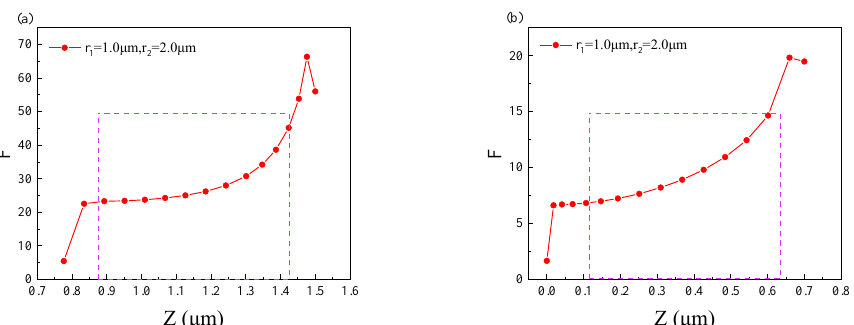
Figure 5. The variation of the enhancement factor F in the two quantum well layers with the coordinates Z: ( a ) variation in QW1 and ( b ) variation in QW2.